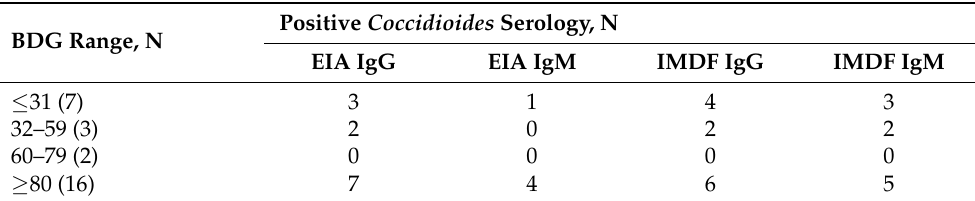
Table 2. BDG range compared to positive Coccidioides serology among culture positive coccidioidomycosis